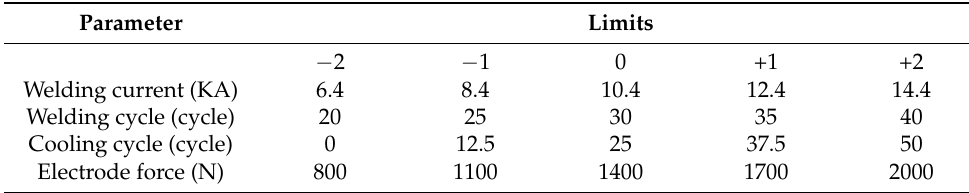
Table 2. Coded and actual values of parameters for the RSW investigations.